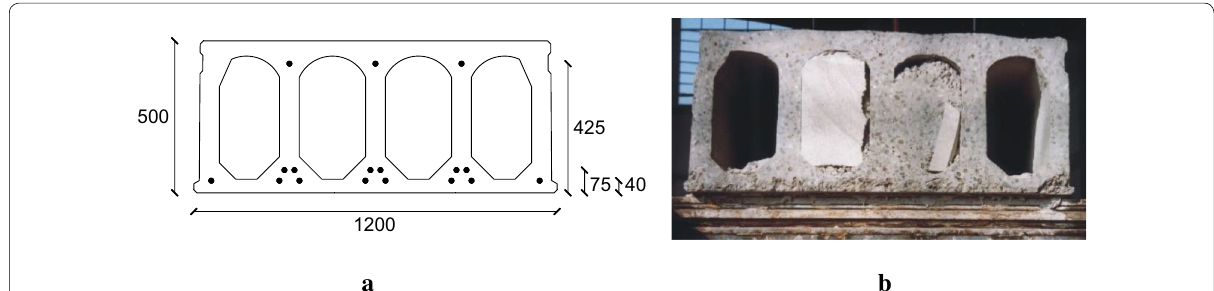
Fig. 1 a Sketch of the cross-section geometry and of the arrangement of prestressing reinforcement for the tested hollow core units (dimensions in mm); b cross-section of specimen H50-f near the supports.